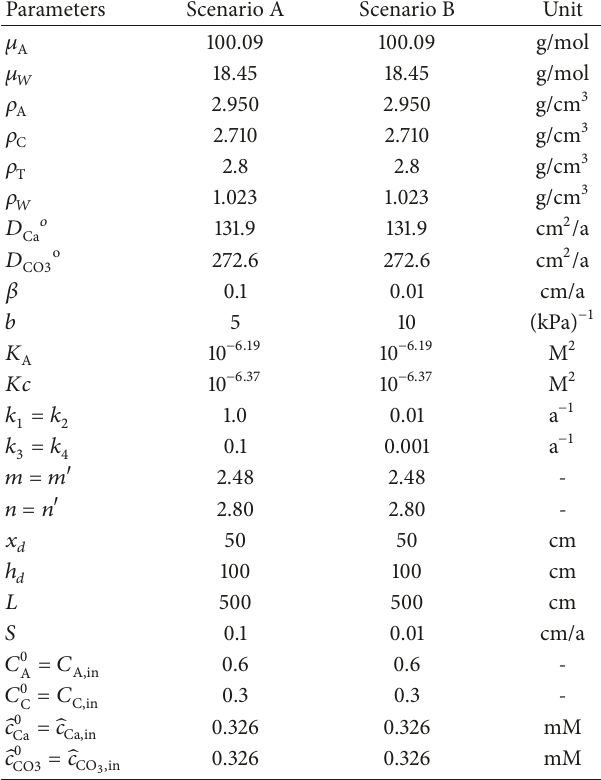
Table 1: Parameter values and initial conditions adopted in two base